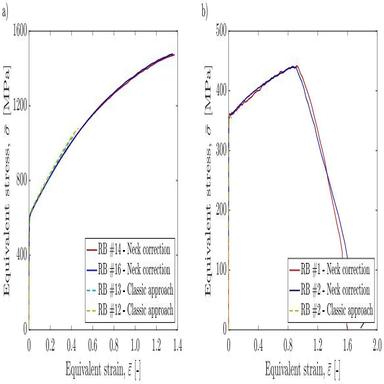
Equivalent stress - equivalent strain: (a) stainless steel 304L; (b) copper C110.